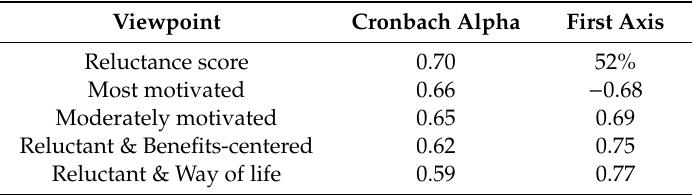
Table A1. Reluctance to propose the HCRCT score: internal consistency and unidimensionality of the items (ANRS-APSEC study, n =